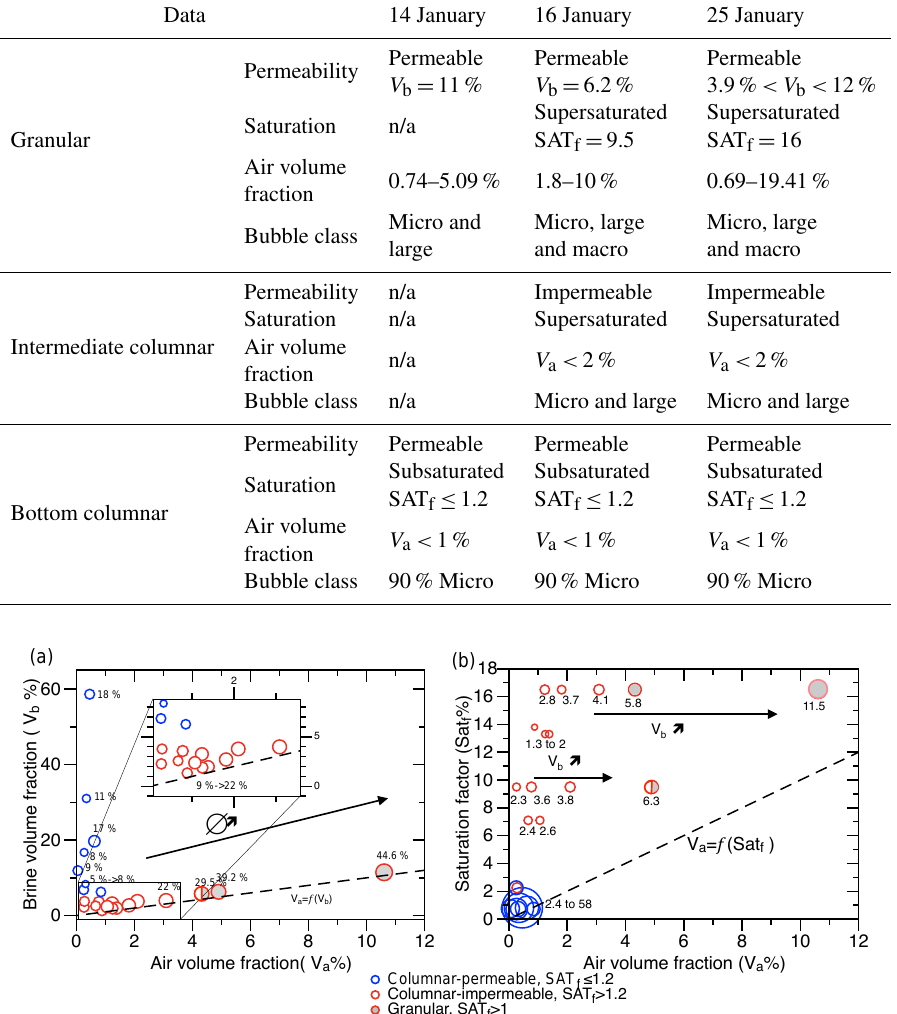
Table 5. Physical characteristics of the various ice types. Where the brine volume exceeds the permeability threshold for columnar ice of 5% V b (Golden et al., 1998, 2007), the ice layer is referred to as permeable.